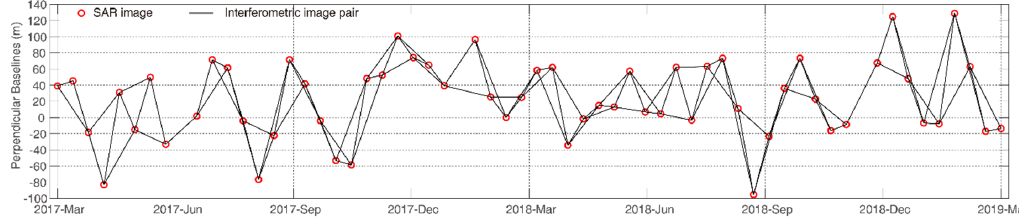
Figure 2. Interferometric combinations of Sentinel-1 datasets from path 11 for the time series analysis.